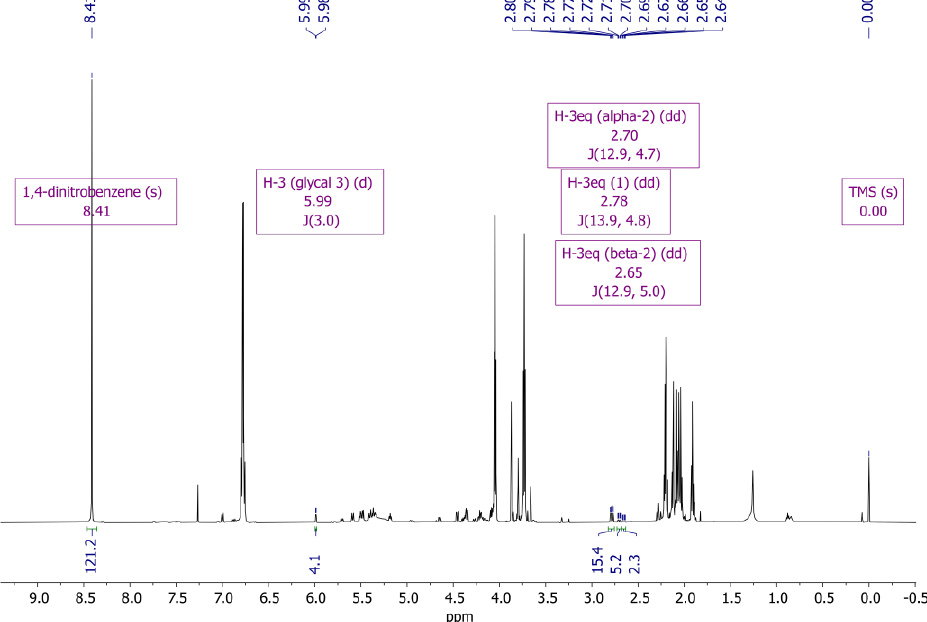
Figure 2. 1 H NMR spectrum (600.13 MHz, CDCl 3 ) of the worked-up reaction mixture (see Table 1, entry 4) illustrating determination of quantities of glycal 3 (5.99 ppm), N -acetylsialyl chloride 1 (2.78 ppm), α- and β-aryl sialosides 2 (2.70 and 2.65 ppm, respectively) relative to the standard—1,4-dinitrobenzene (8.41 ppm) by qNMR. Integral values correspond to the amounts ( µ mol) of the respective